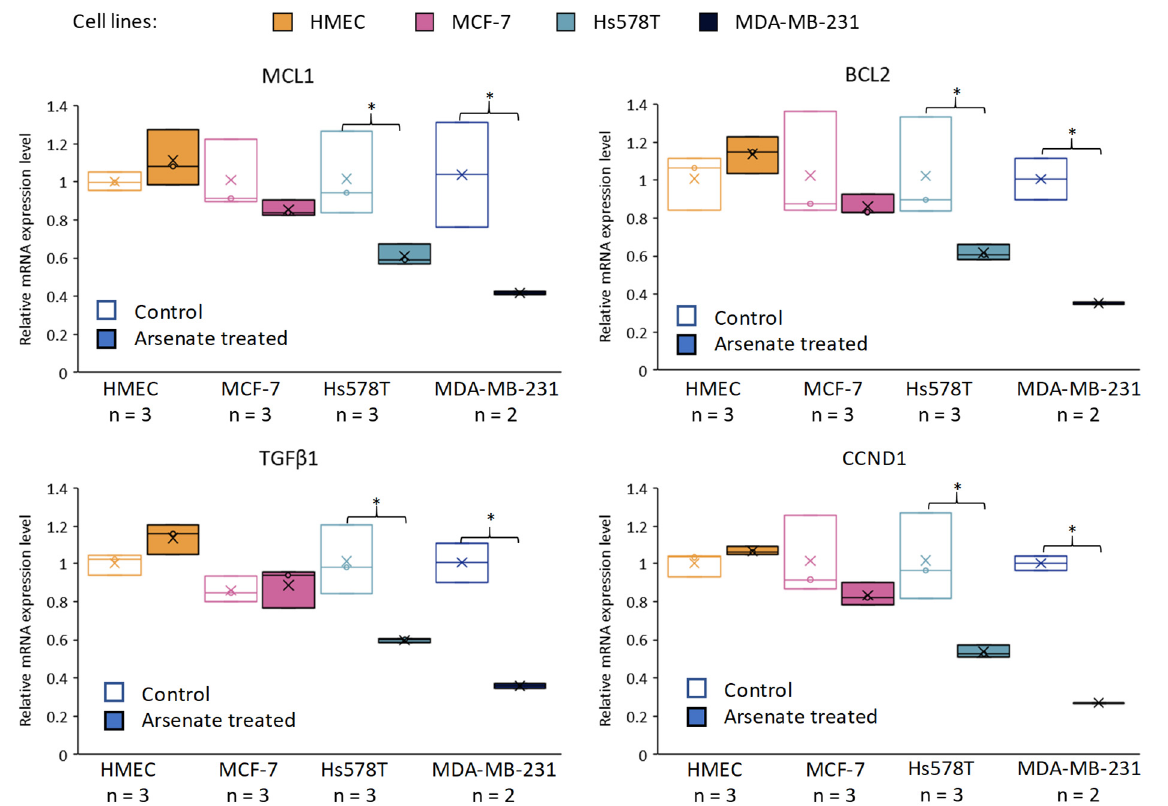
Figure 7. Validation of the effect of arsenate by qRT-PCR on selected genes related to apoptosis and cell proliferation. Relative gene expression levels are shown for MCL1, BCL2, TGF β 1, CCND1 (Cyclin D1) across cell lines and in arsenate treated and control group (untreated cells). The data were normalized to β -actin and B2M using the ΔΔ ct method for the HMEC, MCF-7, Hs578T and MDA-MB-231 cell lines compared to the arsenate treated group versus the control group. x is the mean and the line is the median in the boxplots (* p < 0.05). It can be seen that both apoptosis inhibitors (MCL1 and BCL2) are downregulated after arsenate treatment in TNBC cell lines when compared to untreated cells, but not in the normal and DPBC cell lines. Also, survival factor TGF β 1 and cell proliferation indicator CCND1 are downregulated in Hs578T and MDA-MB-231 cell lines compared to their expression in HMEC and MCF-7.